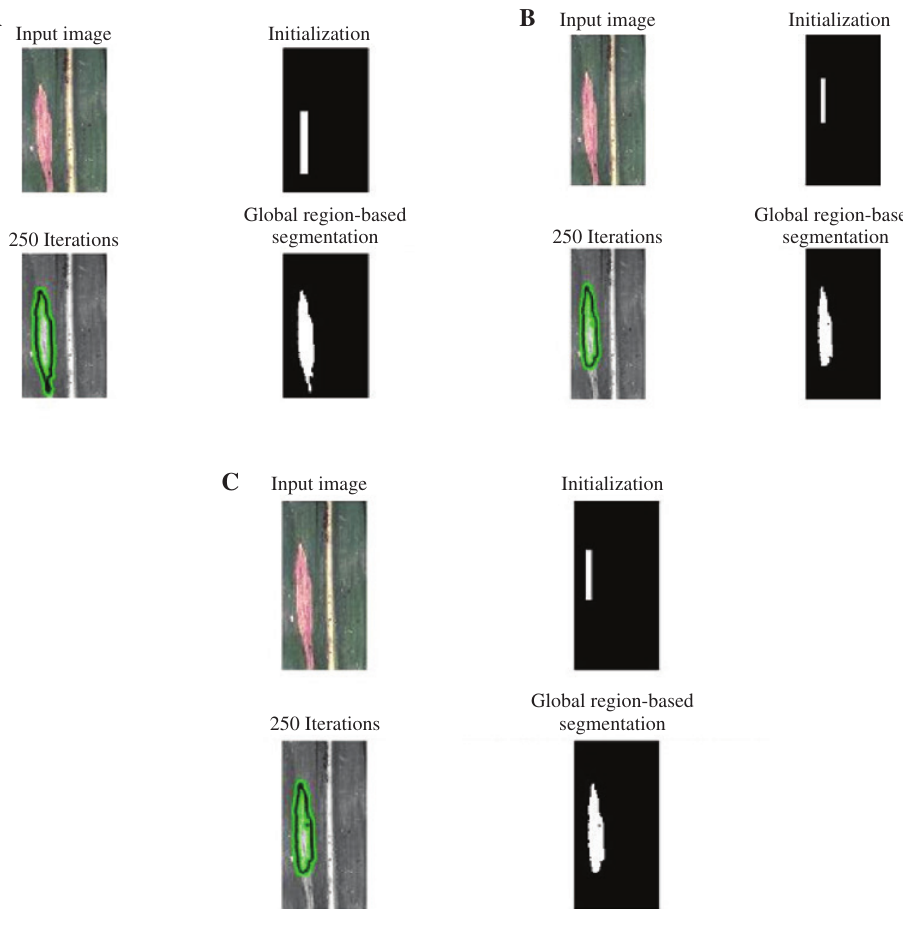
Figure 6: The Output Result of Image